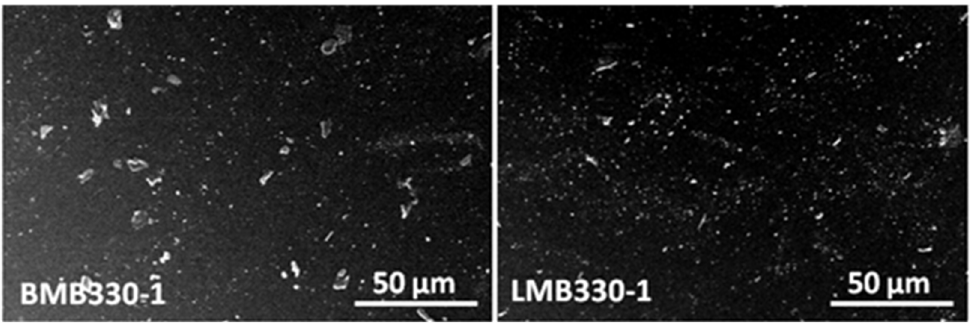
Figure 8. SEM images of BMB330-1 and LMB330-1.